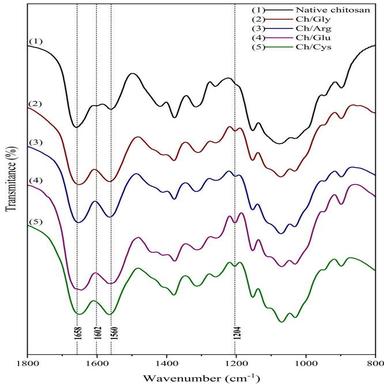
FT-IR spectra of native chitosan and its derivatives.